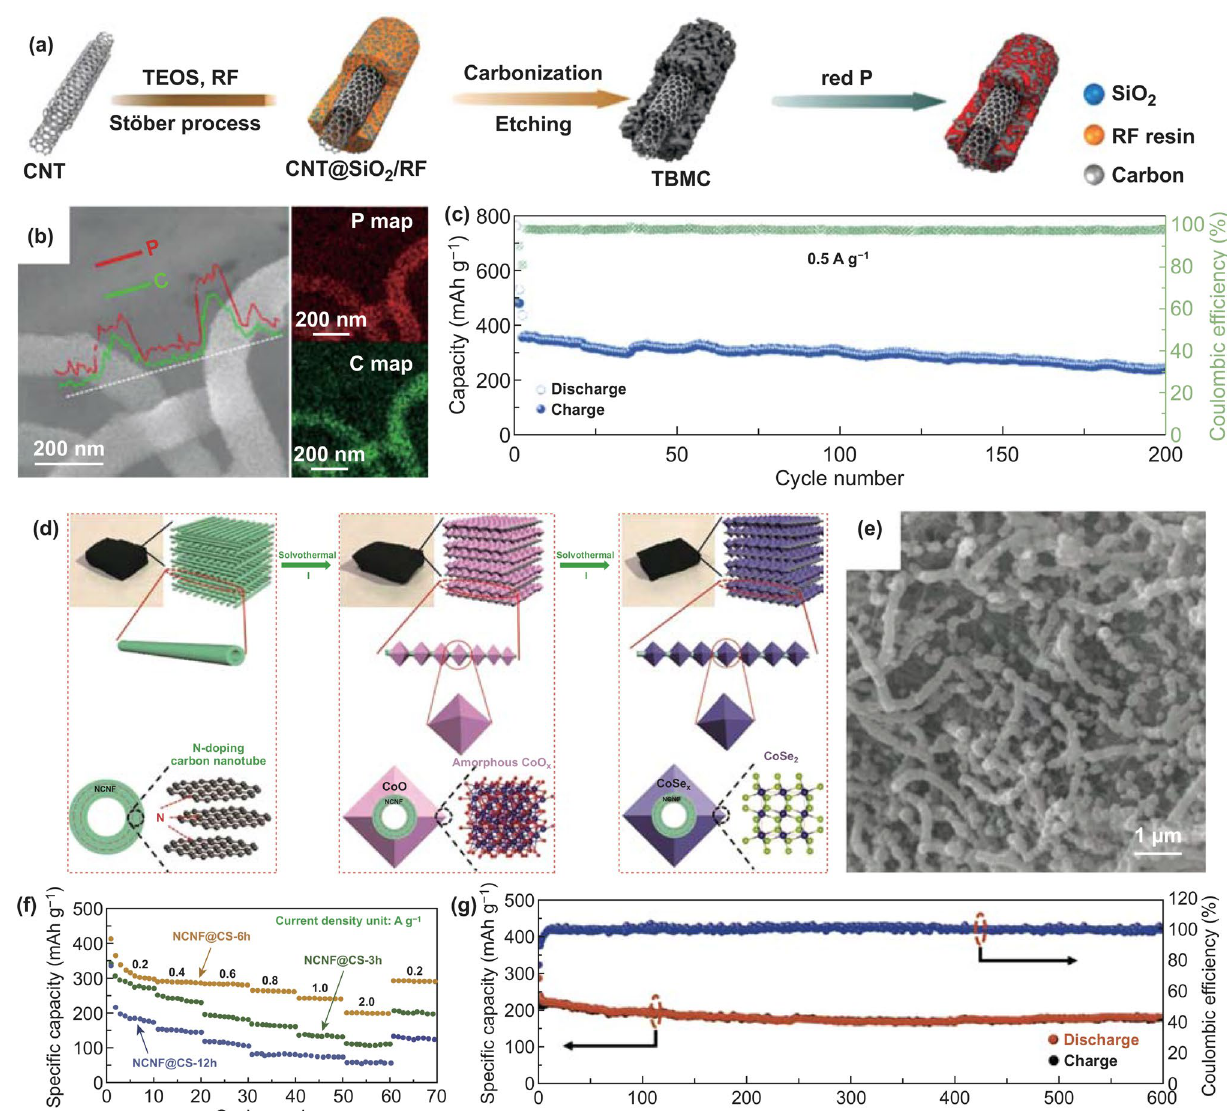
Fig. 6 a Schematic diagram for P@TBMC composite’s fabrication process. b The corresponding EDS elemental mapping and line scanning of P@TBMC-2.4 displayed in SEM image. c Long-term cycle capacities at 0.5 A g −1 after initial two-cycle activation at 0.05 A g −1 . Reproduced with permission from Ref. [50]. Copyright 2018, Elsevier. d Schematic diagram for NCNF@CS’s preparation process. e SEM image of NCNF@ CS-6 h. f Rate capacities of the obtained three NCNF@CS samples. g Long-term cycling stability and C.E. of NCNF@CS-6 h at 2.0 A g −1 over 600 cycles. Reproduced with permission from Ref. [51]. Copyright 2018, John Wiley and